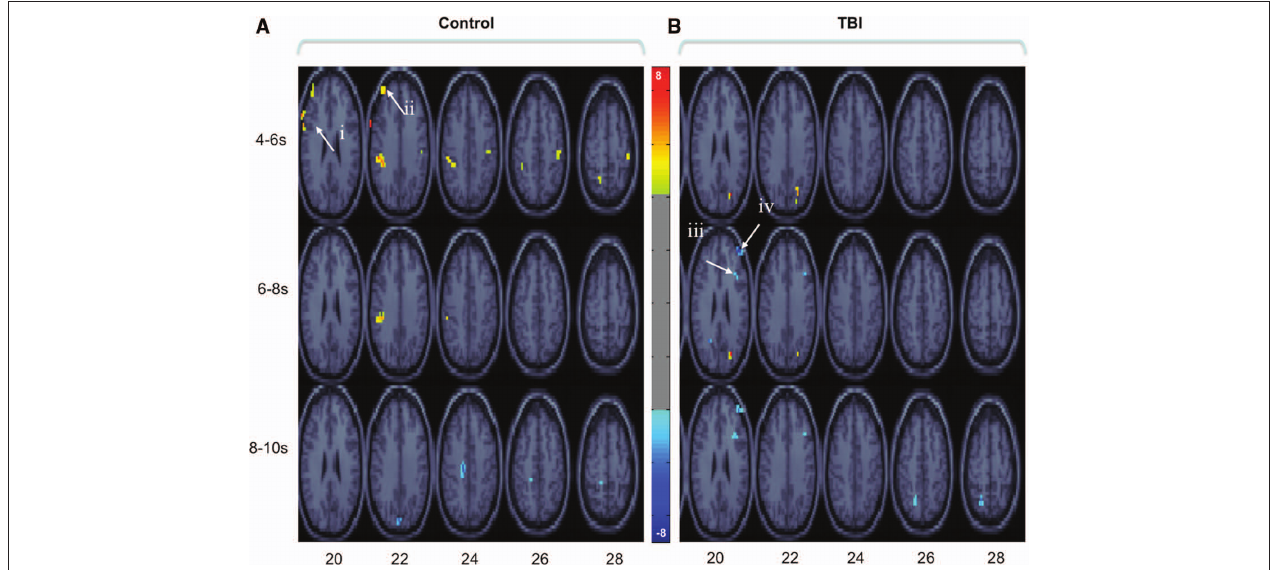
regions with the most reliable and positive brain and behavior correlations across all tasks. Talairach coordinates ( x , y , z ) of cluster maxima: (i) left inferior frontal gyrus (GFi: − 67, 9, 29); (ii) left middle frontal gyri (GFm: − 40, 48, 23); (iii) right posterior middle frontal gyrus (pGFm: 36, 21, 25); (iv) right anterior middle frontal gyrus (aGFm: 40, 47, 16). These voxels are used as seed regions in subsequent seed and behavior PLS analyses (see text and Figures 3 and 4)